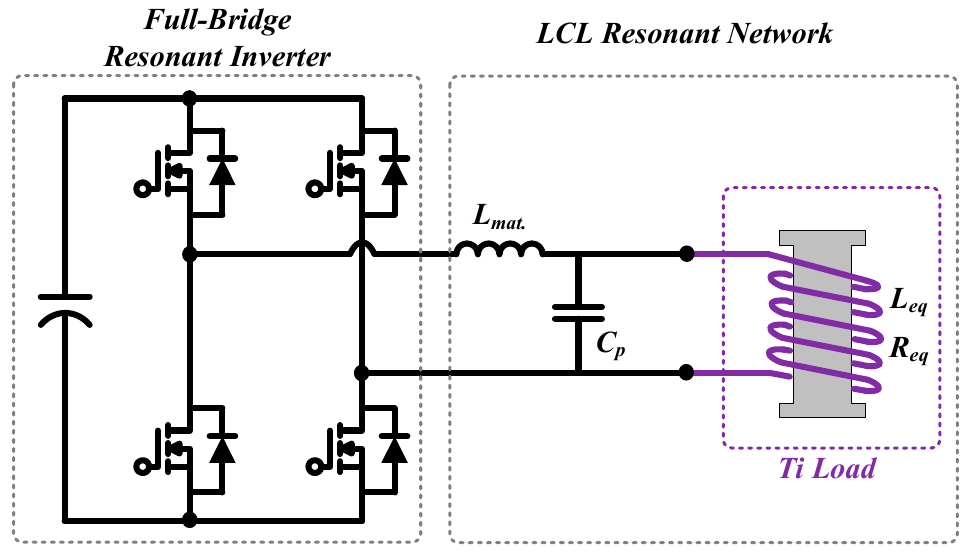
Figure 11. Ti load with LCL topology structure.